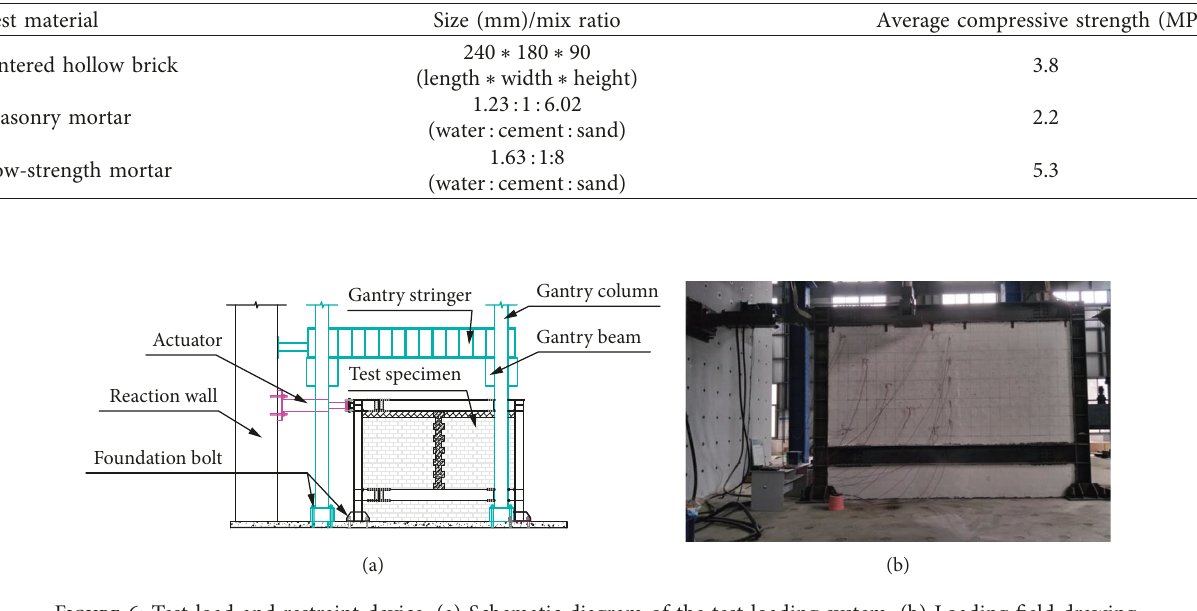
Figure 6: Test load and restraint device. (a) Schematic diagram of the test loading system. (b) Loading field